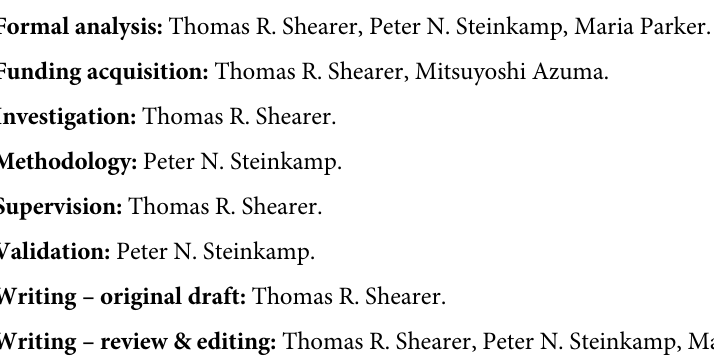
S1 Table. Retinal thicknesses in the quadrants of the inner (3 mm) and outer (6 mm) rings from non-BRAO eyes (n = 8 or 9). S2 Table. Predicted change in GCL layer during BRAO. S3 Table. Effect size (Cohen-D) used for determining samples